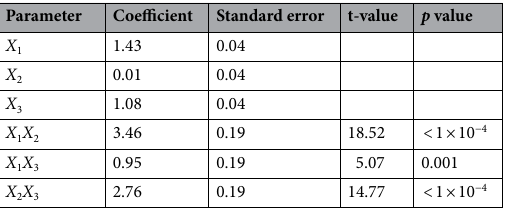
Table 4. ANOVA results of the quadratic model for biomass production of L. sakei ACU-2. X 1 Yeast extract; X